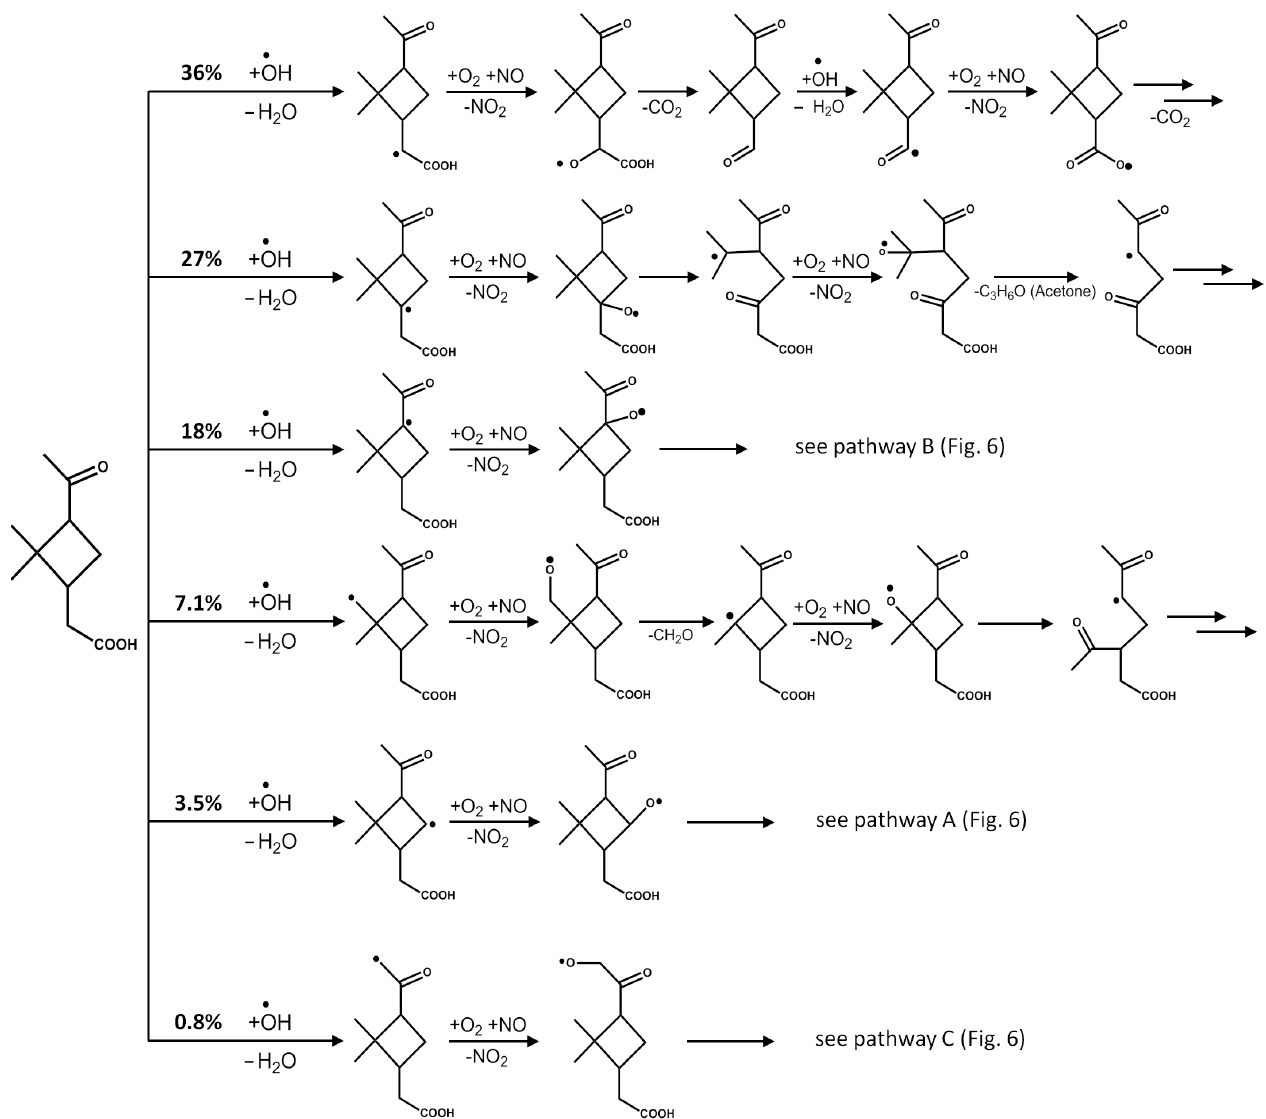
Fig. 5. Initial reaction steps of hydroxyl radical oxidation of pinonic acid by OH